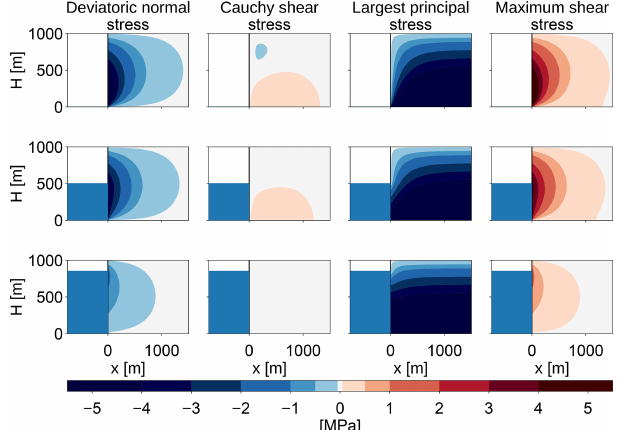
Figure A1. Stress configurations at the calving front for different relative water depths ( w = 0, 0.5, 0.85) for a fixed ice thickness of 1000m. The first column shows the deviatoric normal stress in the x direction, S xx , the second column shows the Cauchy shear stress, σ xz = S xz , the third column shows the largest principal stress, σ i , and the last column shows the maximum shear stress, τ max